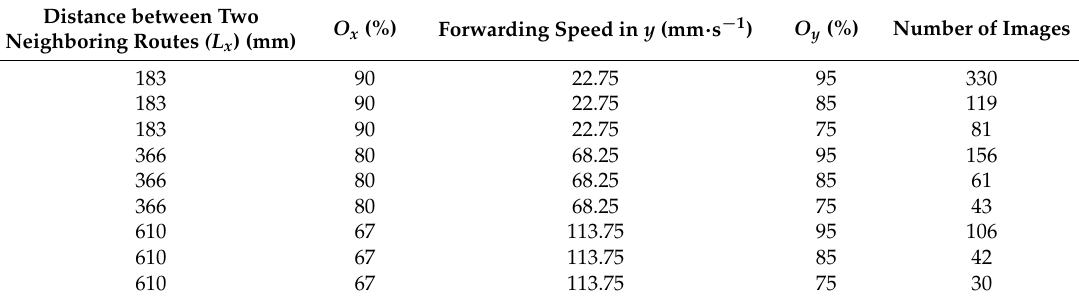
Table 2. Overlaps and number of images for processing 3D reconstruction